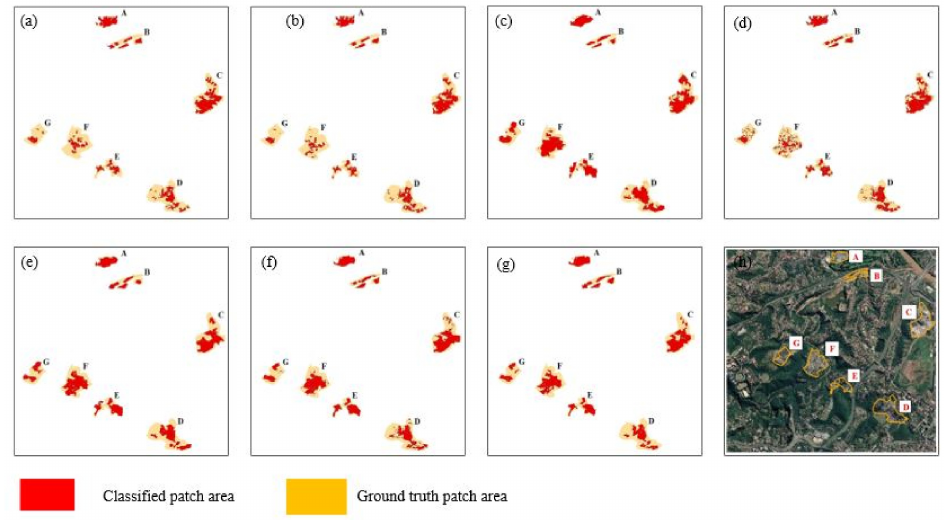
Figure 6. Classified informal settlement patch areas (A–G (black)) for models ( a ) SBs, ( b ) SIs, ( c )Txts, ( d ) SBs + SIs, ( e ) SBs + Txts, ( f ) SIs + Txts, ( g ) SBs + SIs + Txts, and ( h ) corresponding ground truth polygons (A–G